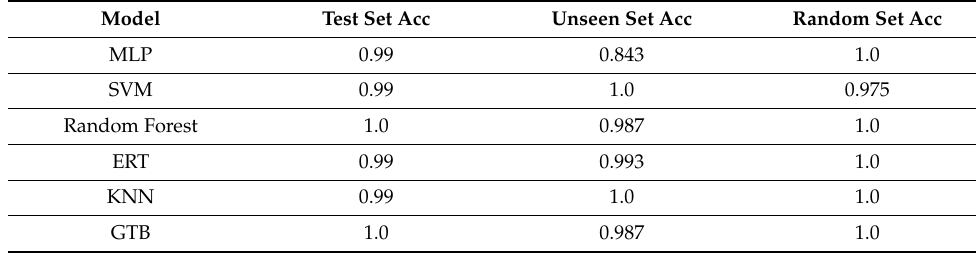
Table 4. Accuracy of classification models for hybrid RF–acoustic features.